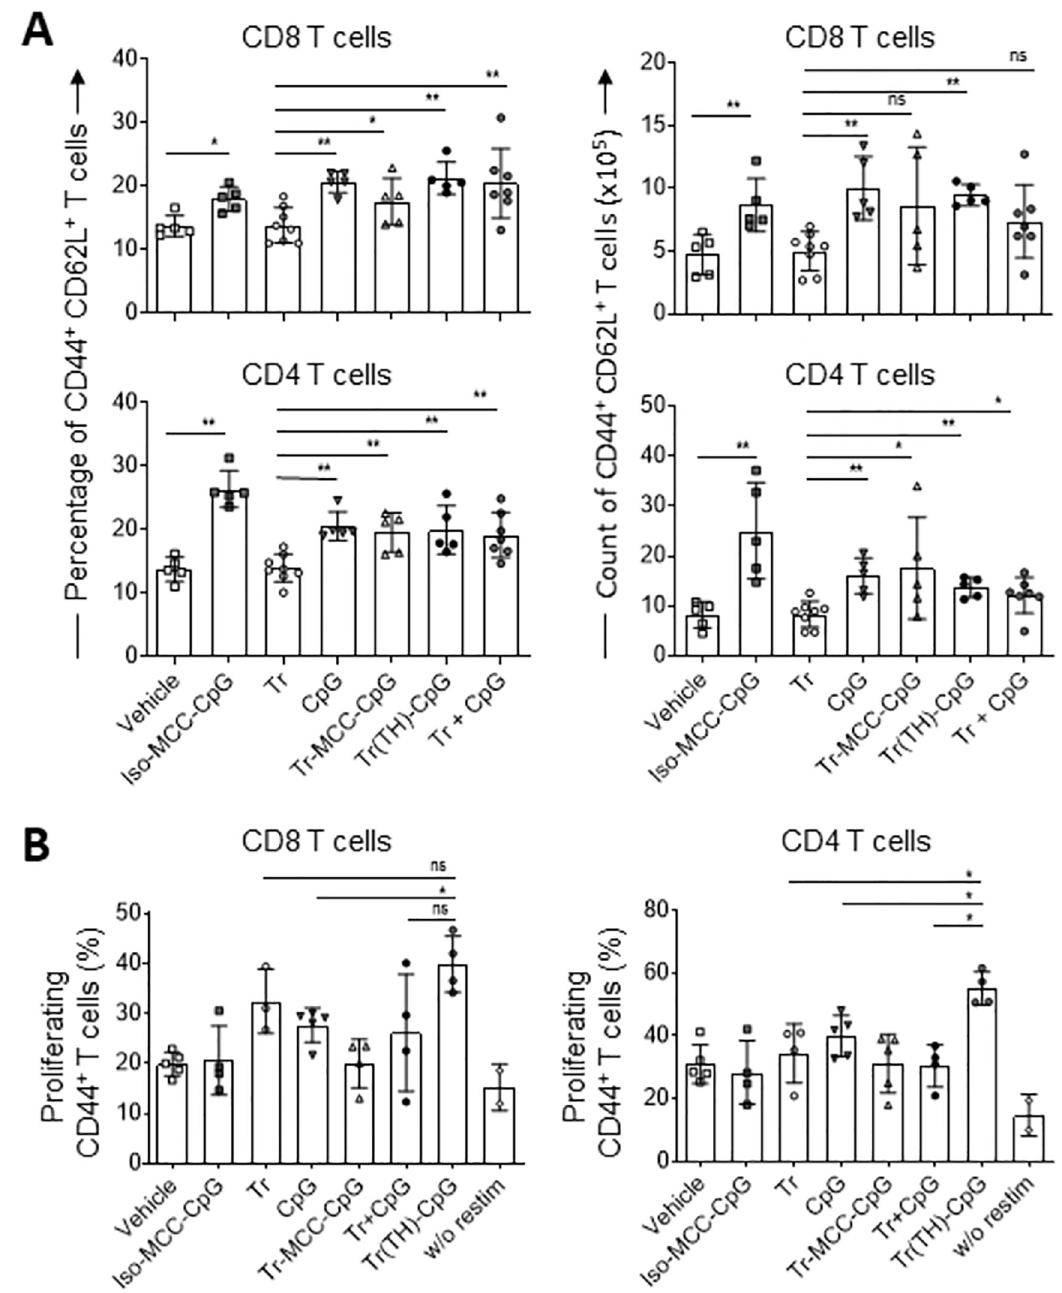
Fig 7. Cellular immune responses in mice upon repeated treatment with TH-Trastuzumab-MCC-CpG. Mice were treated on days 4, 8 and 11 post tumor inoculation with 2mg/kg body weight of the indicated antibodies or antibody conjugates or with a dose of free CpG equivalent to the CpG dose applied in conjugated form. Splenocytes were isolated on day 18. (A) Splenocytes were stained and analyzed ex vivo by flow cytometry to determine the percentage and the absolute counts of activated CD44 + CD62L + central memory CD4 + and CD8 + T cells in the samples. Each symbol represents a mouse treated with vehicle (n = 5), Iso-MCC-CpG, Tr-MCC-CpG, Tr(TH)-CpG or Tr (n = 8 for each), and Tr + CpG (n = 7). Means ± SD of samples from two independent experiments are depicted. Data were analyzed by Mann-Whitney two tailed test; � p < 0.05; �� p < 0.01; ns—not significant. (B) Splenocytes were labelled with CFSE and incubated with an antigen mix and antigen-presenting cells for 72h. The cells were harvested and the percentage of proliferating CD44 + CD4 + and CD8 + T cells was determined by flow cytometry. Each data point represents an individual mouse (n = 4 or 5). Bars show mean values ± SD. Mann-Whitney two tailed tests; � p < 0.05; ns—not significant. Data are from one